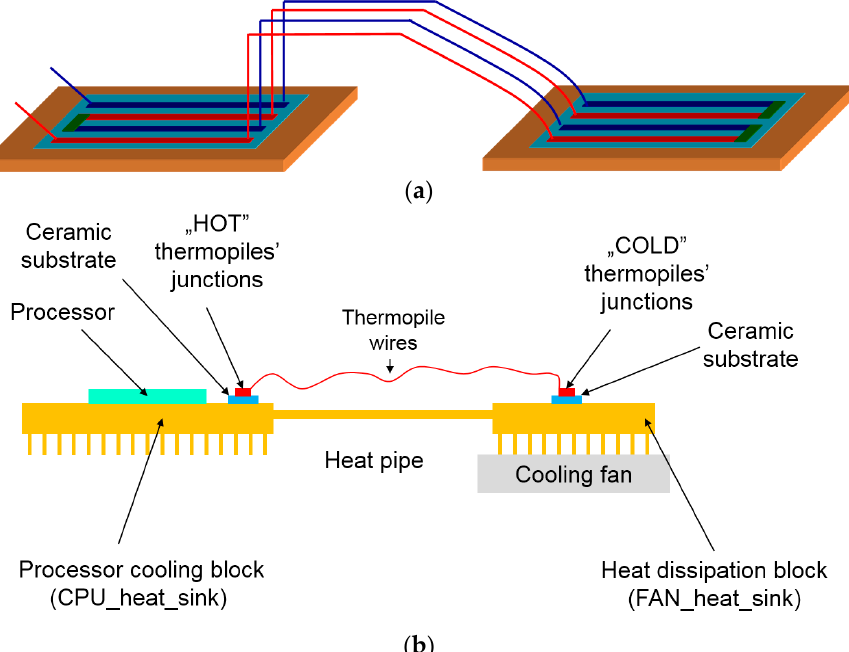
Figure 7. Hybrid thermopile: ( a ) thermocouples printed on ceramic substrates, connected by thermoelectric wires; ( b ) schematic diagram of the hybrid wire/thick-film thermopile.